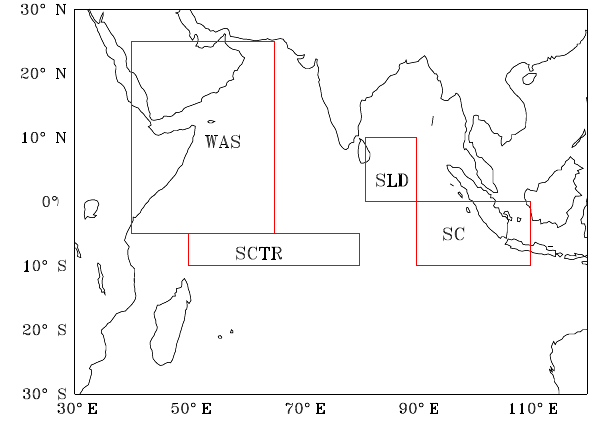
Figure 1. Red boxes shows the study regions (1) WAS (western Arabian Sea, 40–65 ◦ E, 5 ◦ S–25 ◦ N), (2) SLD (Sri Lanka Dome, 81–90 ◦ E, 0–10 ◦ N), (3) SC (Sumatra coast, 90–110 ◦ E, 0–10 ◦ S) and (4) SCTR (Seychelles–Chagos thermocline ridge, 50–80 ◦ E, 5– 10 ◦